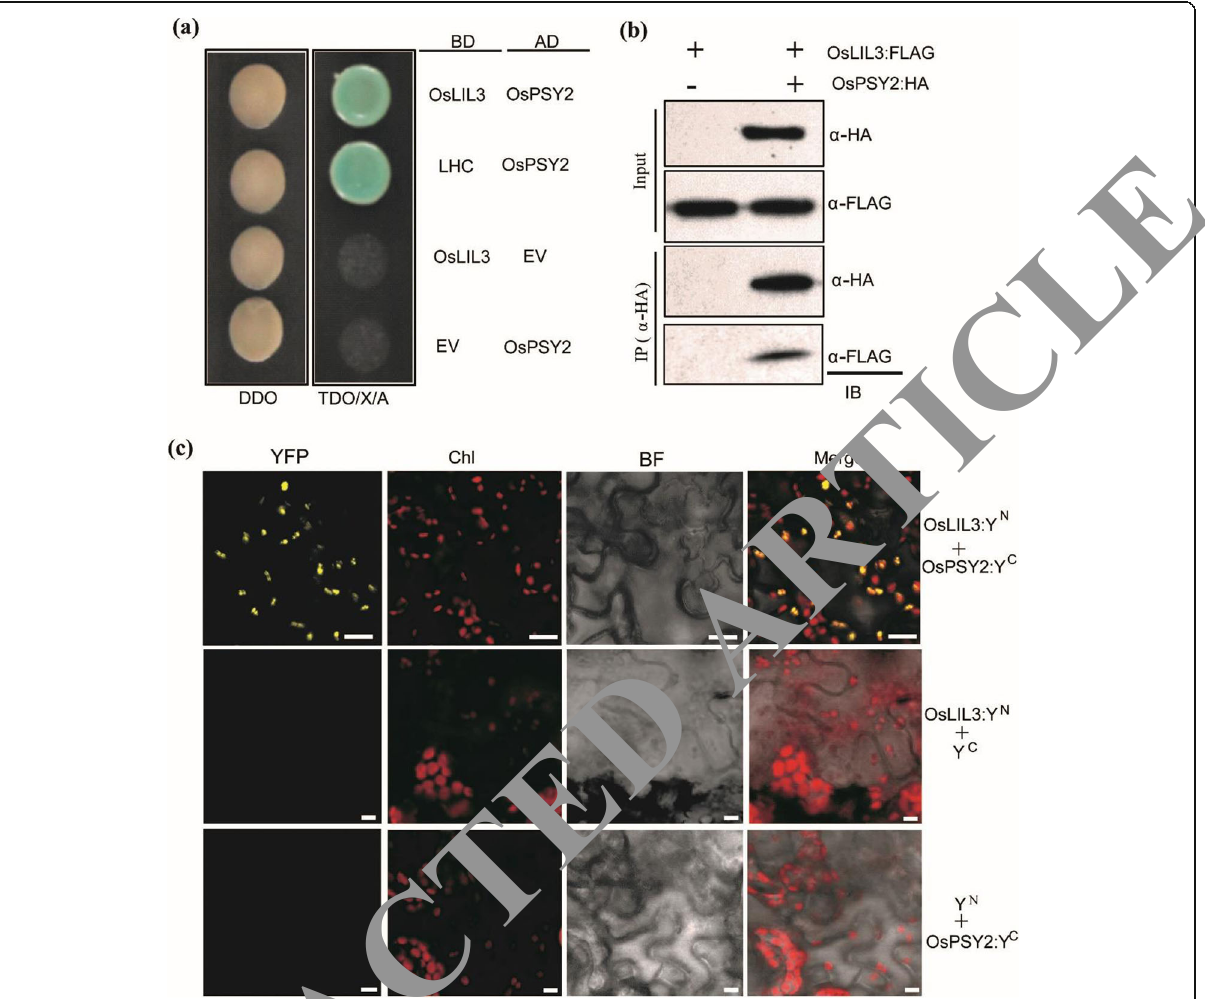
Fig. 4 Protein-protein interaction between OsLIL3 and OsPSY2. ( a ), Yeast two hybrid assays. OsLIL3 and LHC domains were fused with Gal DNA-binding domain (BD). OsPSY2 was fused with Gal DNA-activation domain (AD). The two other combinations OsLIL3/empty (pGADT7 vector) and empty (pGBKT7 vector)/OsPSY2 were included as negative controls. Yeast cells containing various vector combinations were grown on DDO plates (SD – Leu – Trp) for co-transformation selection. Yeast cells showing growth and blue color on high selection TDO/X/A plates (SD-His-Leu- Trp + X-alfa-Gal + Aureobasidin A) confirmed positive interactions between the two indicated proteins. ( b ), OsLIL3-FLAG coimmunoprecipitated with OsPSY2-HA. Total protein was purified from tobacco leaves expressing OsLIL3-FLAG with or without OsPSY2-HA and immunoprecipitated with an anti-Flag or anti-HA antibody. The presence of OsLIL3-FLAG, and OsPSY2-HA in the complex was determined by immunoblot analysis with Flag anti-bodies and anti-HA anti-bodies respectively. ( c ), BiFC-visualized interactions between OsLIL3 and OsPSY2 in N . benthamiana